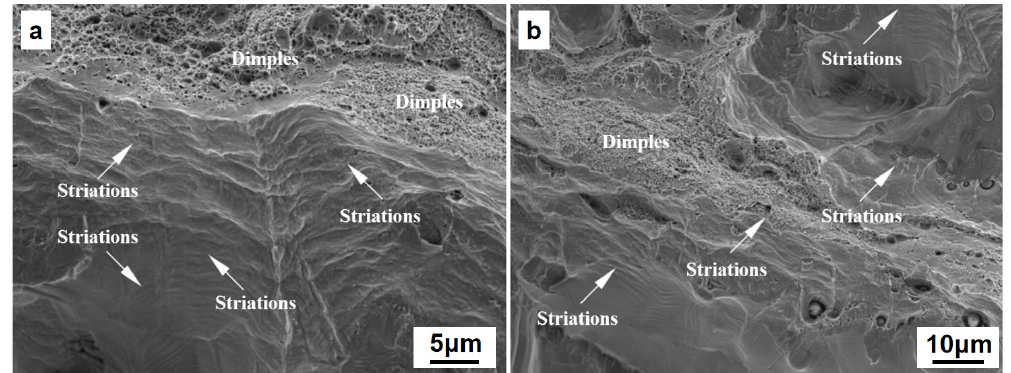
Figure 15. SEM image of typical SLM HEA high-cycle fatigue fracture: ( a ) loading direction is perpendicular to BD; ( b ) loading direction is parallel to BD (note: the arrow indicates the morphology of typical fatigue striations).